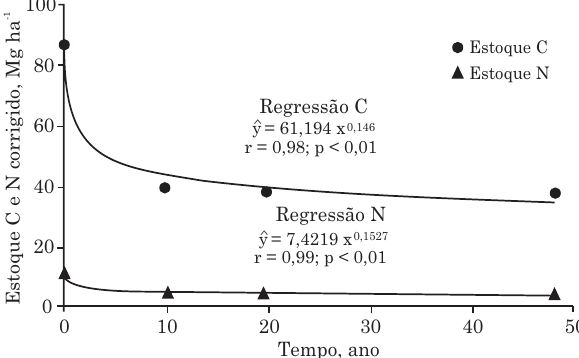
Figura 2. Regressão da variação dos estoques de C e N no solo para a camada de 0-30 cm entre a vegetação natural - Caatinga (tempo = 0) e as situações com diferentes tempos de cultivo da mamona (10, 20 e 50 anos) na Fazenda Floresta, no município de Irecê